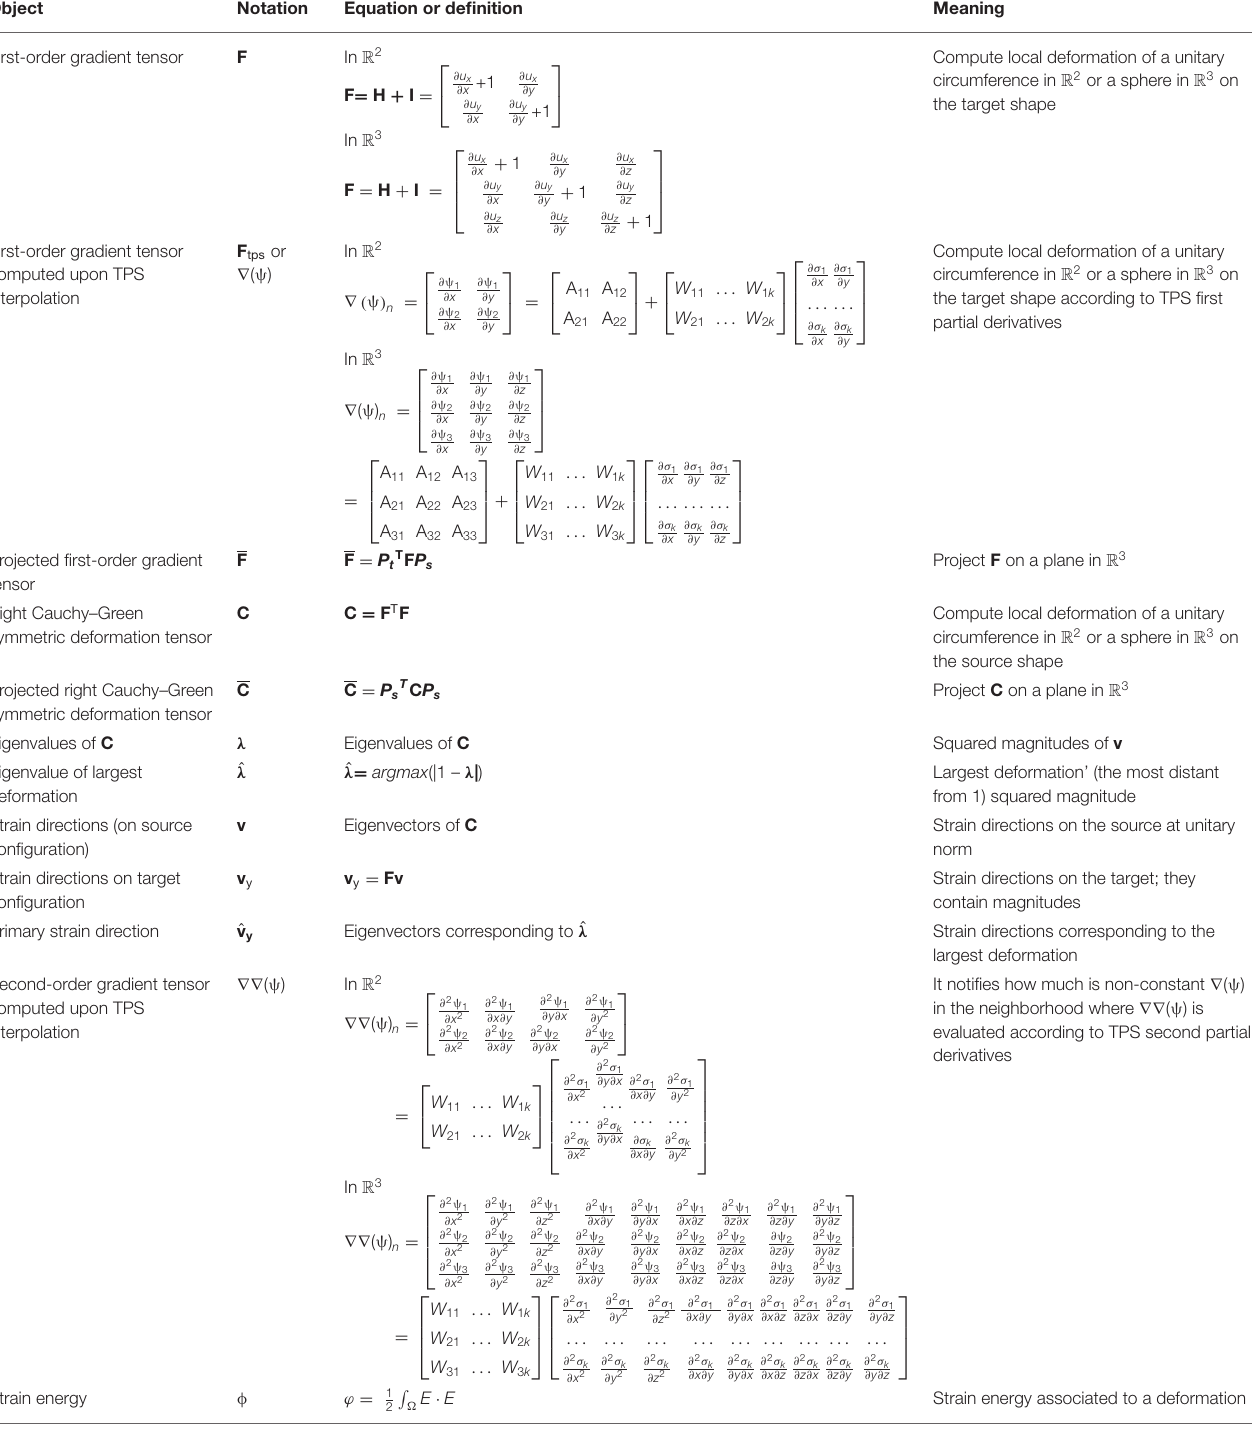
TABLE 1 | Relevant objects used for visualization of local